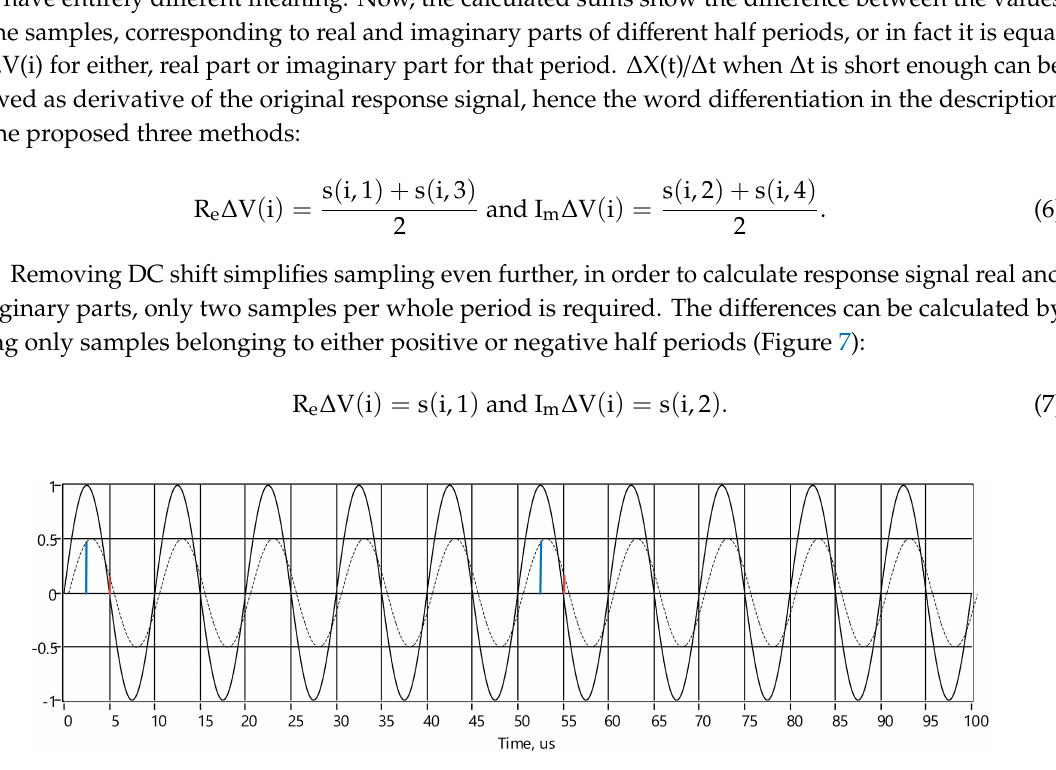
Figure 7. Down-sampling of the response signal using only positive half periods. Solid line is unity magnitude excitation current, dashed line is response voltage. Samples related to the R e V(i) and I m V(i) in blue color and red color